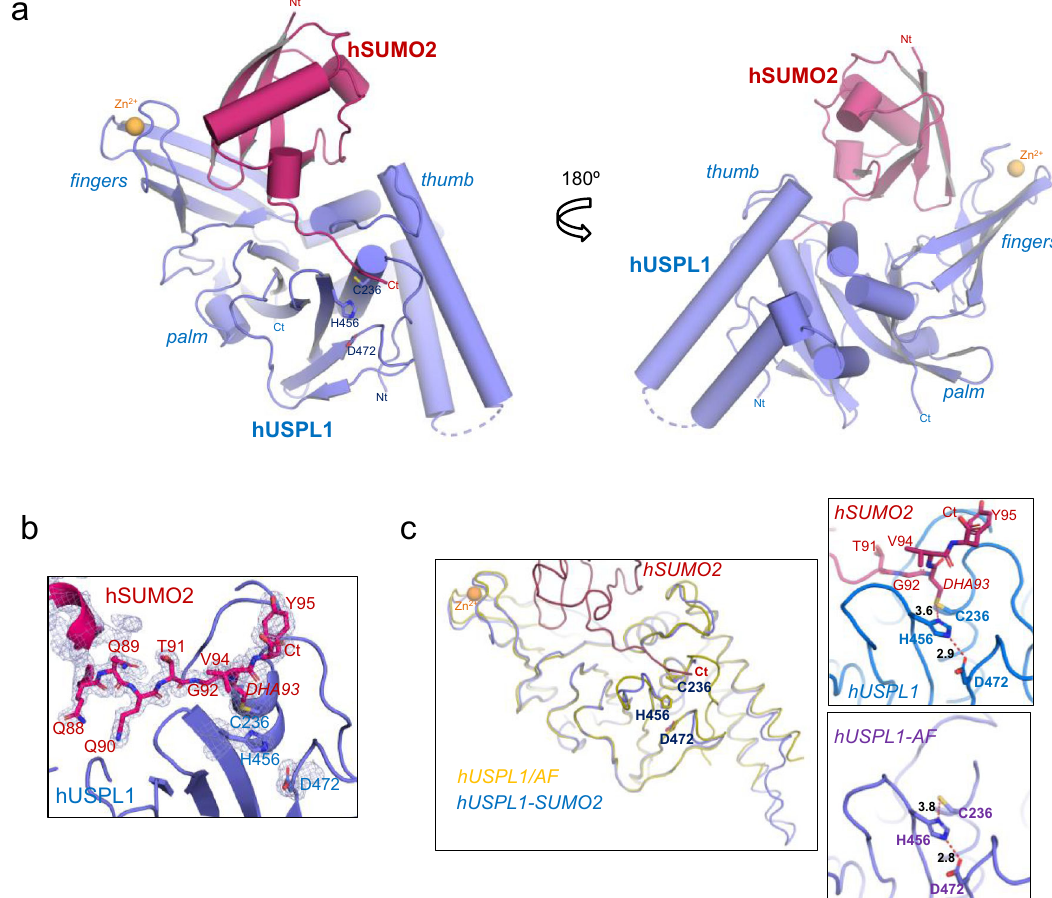
Fig. 2 Crystal structure of the complex of human USPL1 with SUMO2 precursor. a Two views of the USPL1-SUMO2 complex structure are shown in cartoon representation. USPL1 catalytic domain and SUMO2 precursor are shown in purple and red, respectively. USP right hand-like domains are labeled. The catalytic residues are labeled and depicted in stick representation. Zinc atom is shown in yellow. b Detailed view of the 2Fo-Fc electron density map contoured at 1 σ of the C-terminal tail of SUMO2 bound to USPL1. Same color code as in ( a ). c Structural superimposition between USPL1-SUMO2 (blue) complex and the USPL1 AlphaFold (AF) model (yellow). Close-up views of the superimposition of active sites of USPL1 and AF model are shown in the right panel. Catalytic triad residues from USPL1 are labeled and shown in stick representation, whereas the corresponding residues from AF model are shown below. Hydrogen bonds are represented by dashed lines and the distances (Å) are also